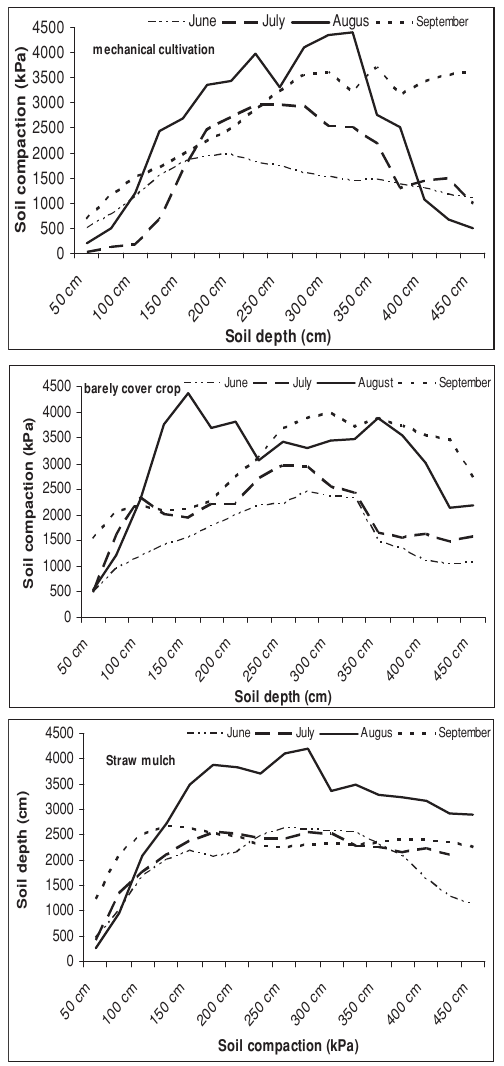
Figure 1. Soil compaction, depending on the soil depth in case of mechanical cultivation, barely cover crop and straw mulch, from June to September (Tokaj, 2008)